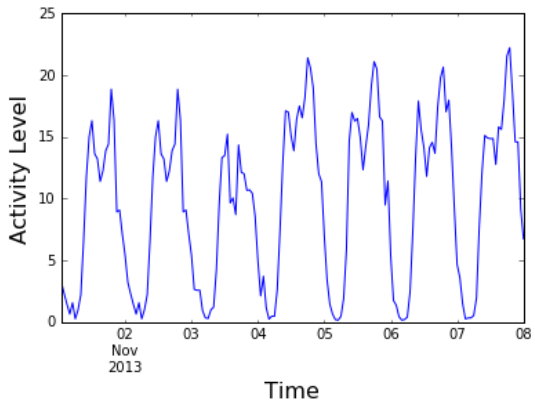
Figure 9. Variation of CDR activity over a week period.